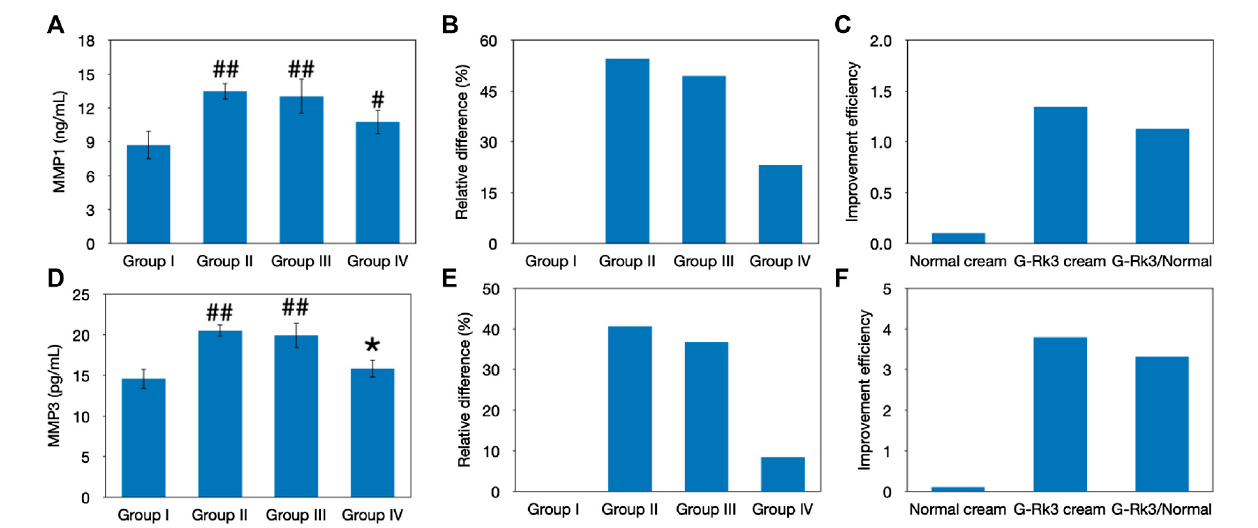
FIGURE7| EvaluationofMMPs.ChangesinthelevelsofMMP-1 (A – C) andMMP-3 (D – F) .Theabsolutevalue (A,D) .##Verysigni fi cantlydifferentfromgroupI, p < 0.01.#Signi fi cantlydifferentfromgroupI, p < 0.05.*NotdifferentfromgroupI, p > 0.05.Relativedifferencesinthefourgroups (B,E) .Improvementef fi cienciesofnormal and G-Rk3 creams (C, F)